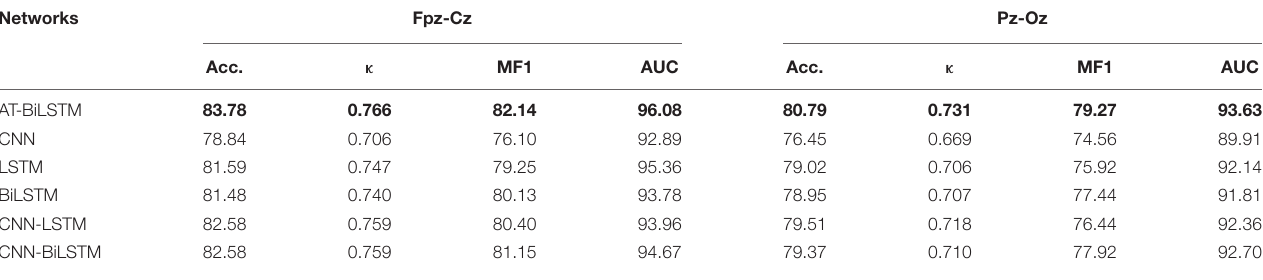
TABLE 3 | The overall performance of different networks on the PSEE dataset (value in bold represents for the best among all the networks). Networks